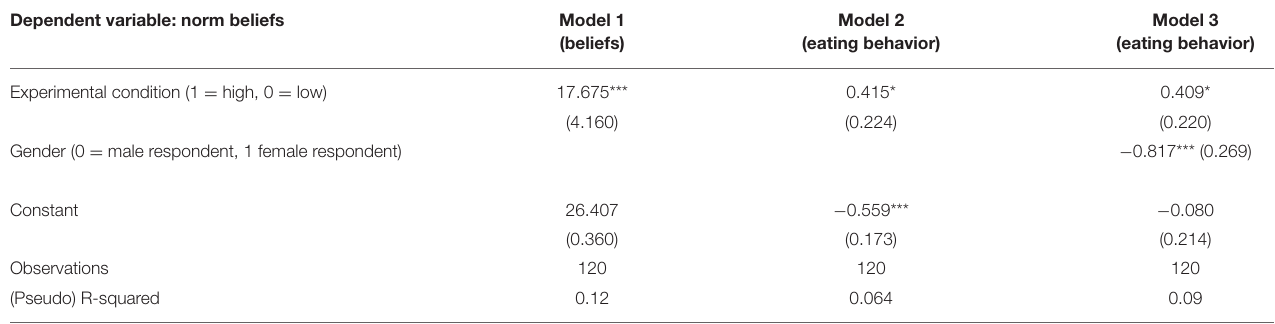
TABLE 3 | Regression models (Study 3, Model 1: OLS; Models 2/3: Probit).